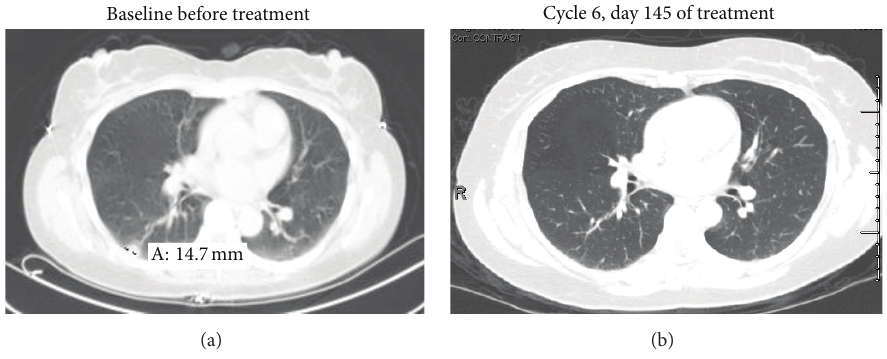
Figure 1: Imaging of patient with complete remission.